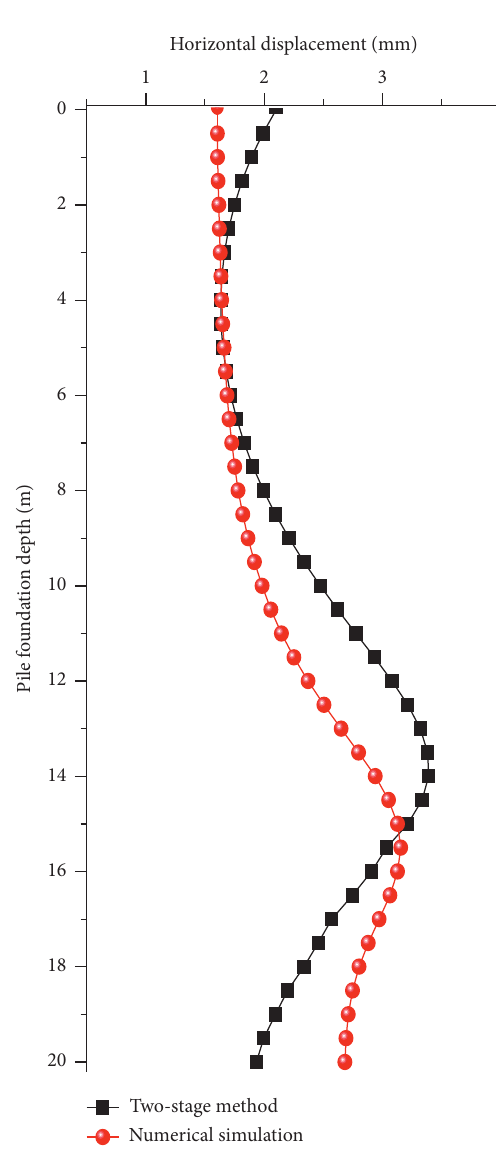
Figure 8: Horizontal displacement of